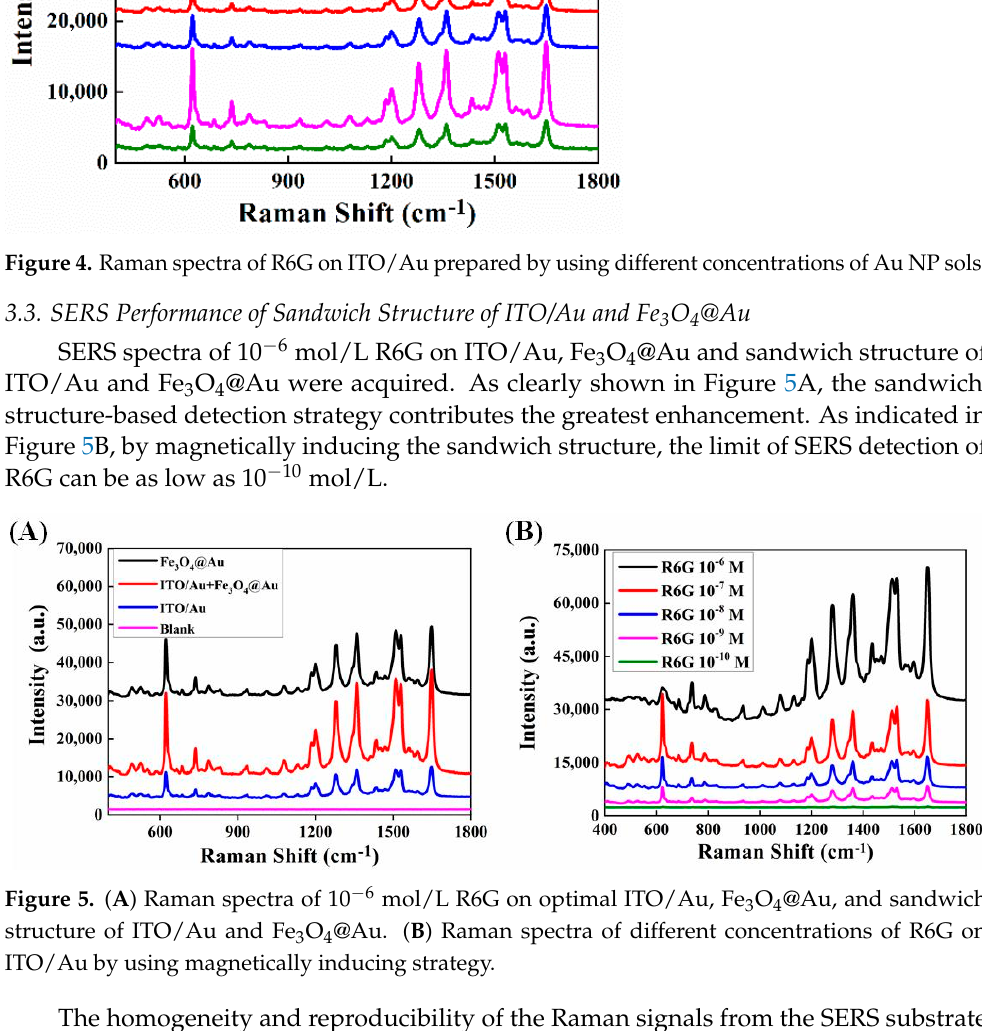
Figure 5. ( A ) Raman spectra of 10 − 6 mol/L R6G on optimal ITO/Au, Fe 3 O 4 @Au, and sandwich structure of ITO/Au and Fe 3 O 4 @Au. ( B ) Raman spectra of different concentrations of R6G on ITO/Au by using magnetically inducing strategy.